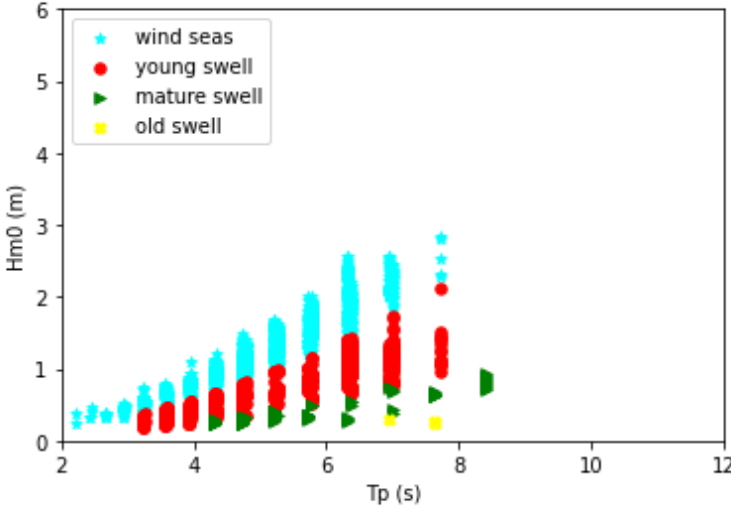
Figure 12. Discrimination of subsets of data corresponding to tombolo formation (subsets: 3_tf and